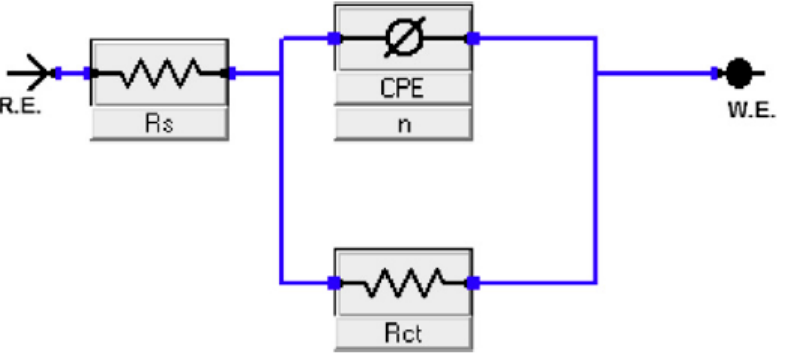
Figure 13. The suggested equivalent circuit model for the studied system.